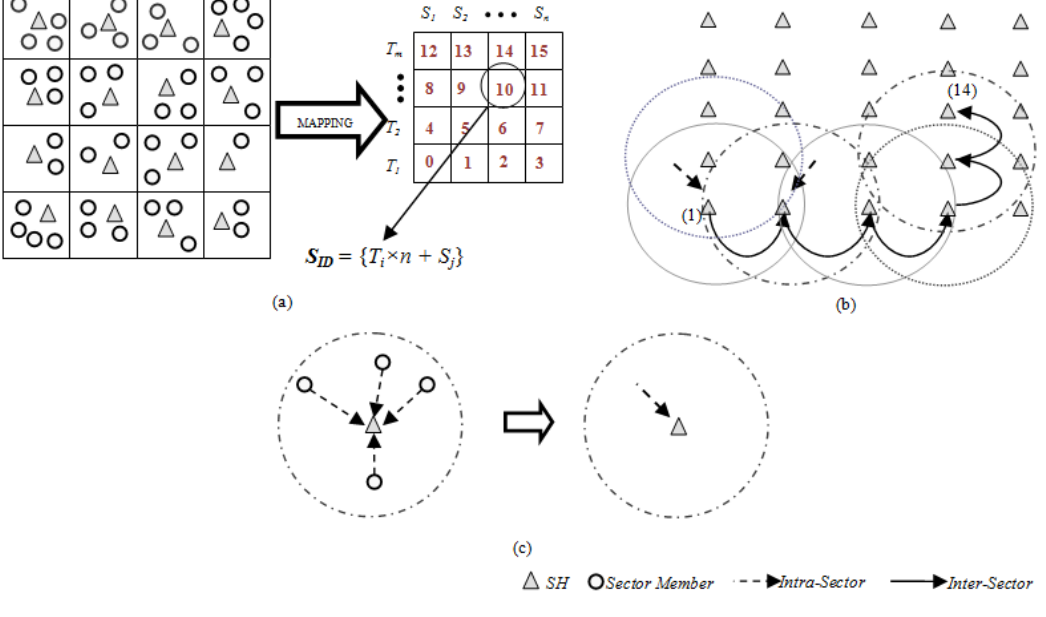
Figure 1. ( a ) DBS mapping; ( b ) inter-sector communication; and ( c ) intra-sector member node to head node